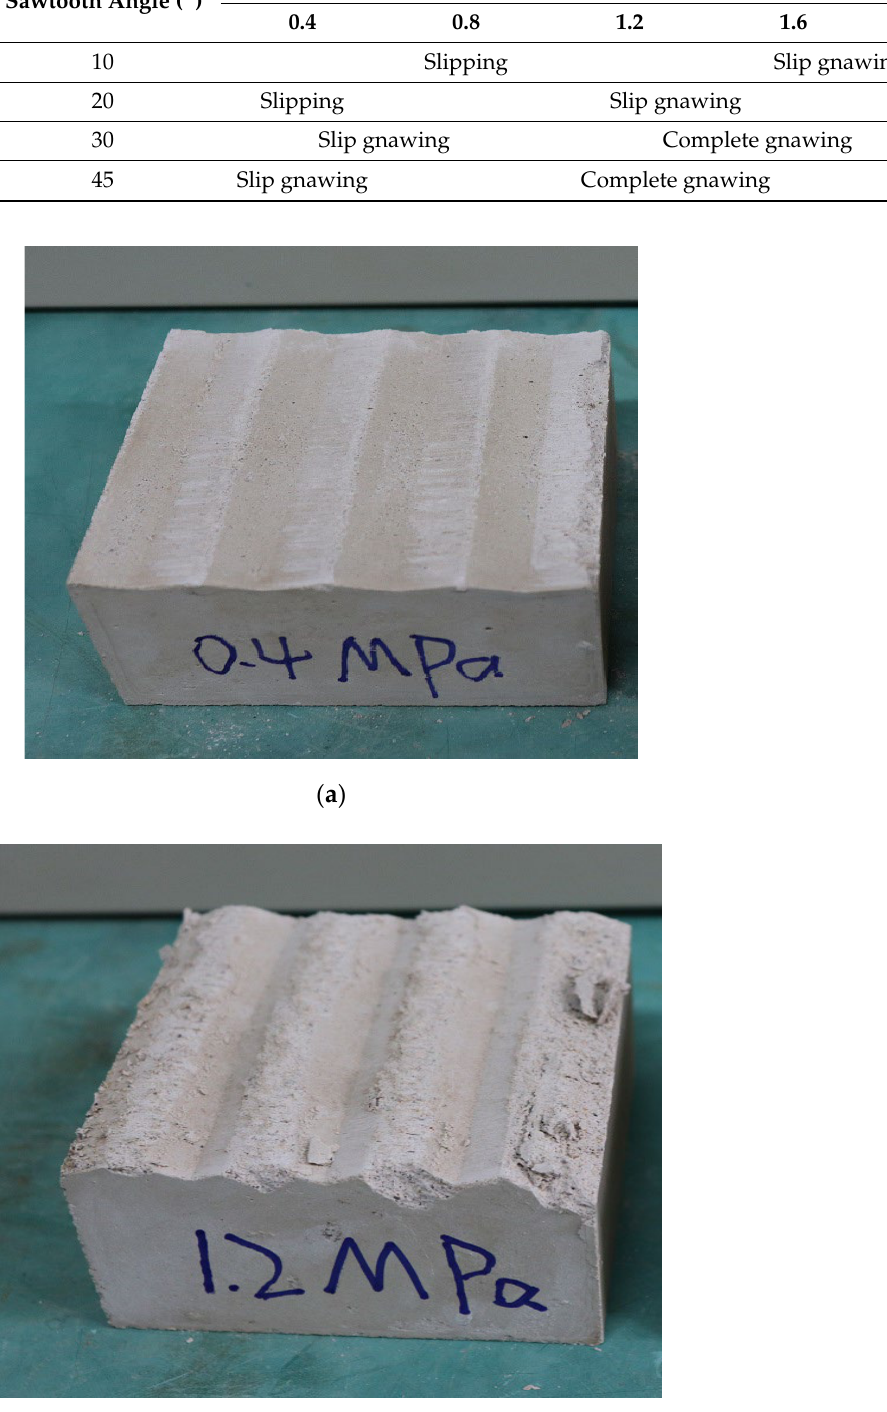
( c ) Figure 9. Saw-toothed sliding gnawing failure mechanism of joints. ( a ) Slip failure at 10° sawtooth angle under 0.4 MPa normal stress; ( b ) Slip gnawing failure at 20° sawtooth angle under 1.2 MPa normal stress; ( c ) Complete gnawing failure at 45° sawtooth angle under 2.0 MPa normal stress.